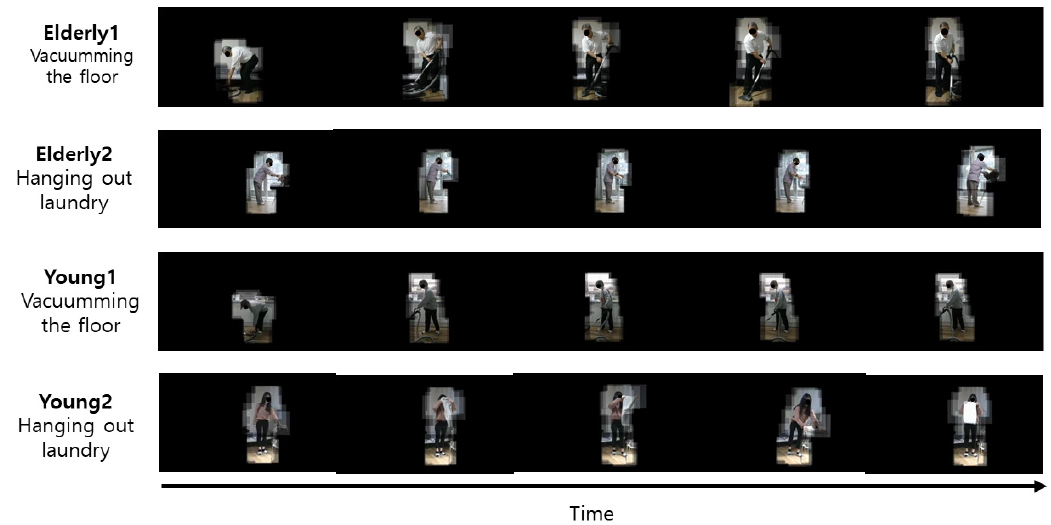
Figure 19. Example of body ROI video with only the body left and the background removed.